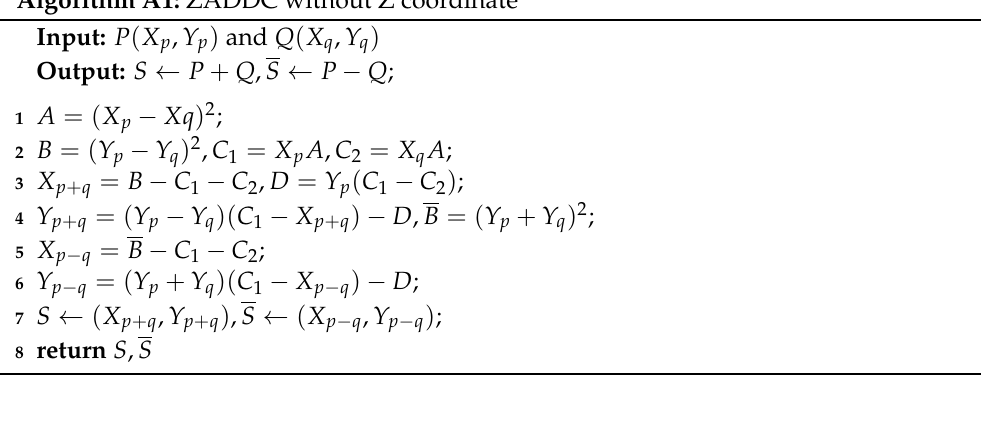
Algorithm A2: ZADDU without Z